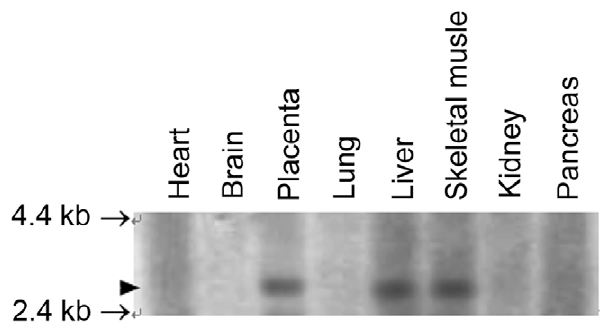
Figure 1. FN1BP1 expression in human placenta, liver, and skeletal muscle tissues. The tissue expression pattern of FN1BP1 (Accession No. AF217970) was investigated by hybridizing its cDNA probe to a multiple-tissue northern blot assay. The mRNA content in the eight lanes are from heart, brain, placenta, lung, liver, skeletal muscle, kidney, and pancreas tissues, respectively. A transcript of , 2.8 kb was observed in human placenta, liver, and skeletal muscle tissues. The arrow (no tail) shows this , 2.8-kb length of the mRNA transcript. The arrows at 2.4 kb and 4.4 kb indicate the mean sizes of the RNA markers.